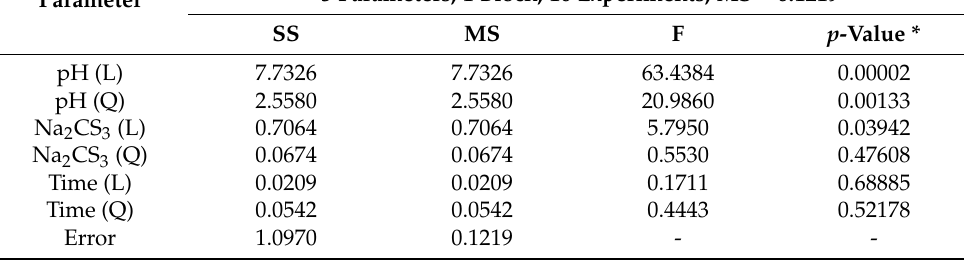
Table 5. Analysis of the CCD/RSM—verification of the adequacy of the model using analysis of variance (ANOVA).